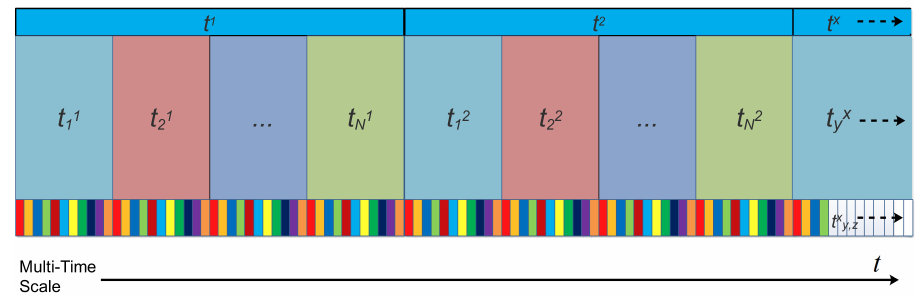
Figure 2. Multi-time scale